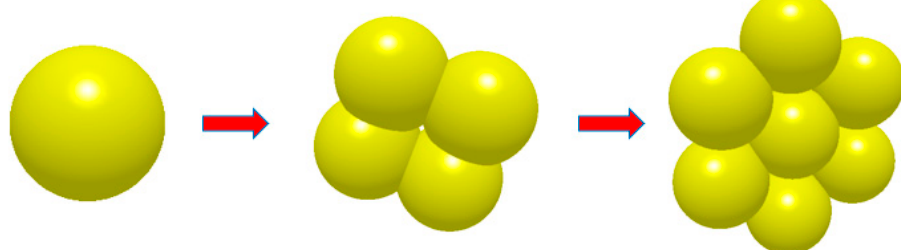
Figure 2. Process of black soldier fly feces adhered to become agglomerations.